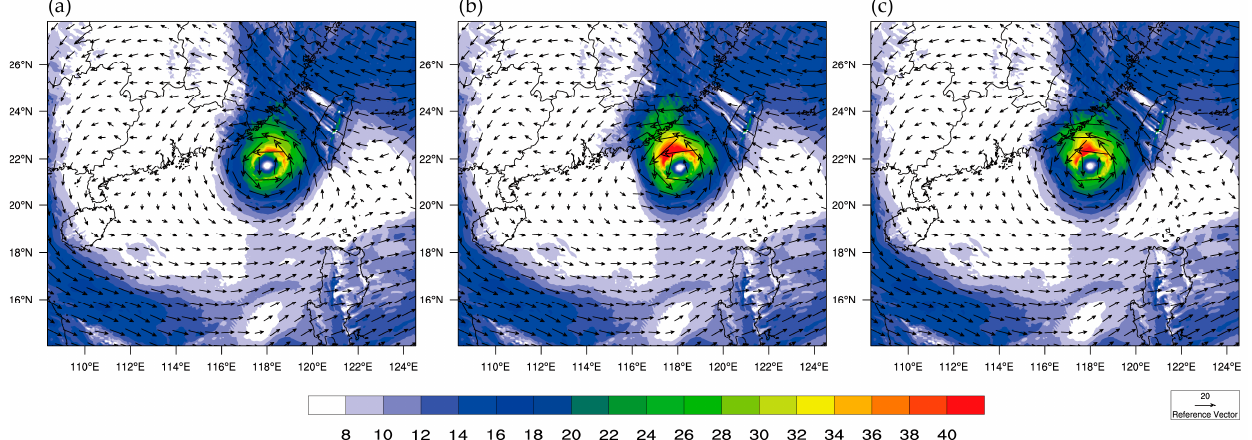
Figure 5. 700 hPa wind speed (shaded, unit: m s − 1 ) and wind vector (arrow, reference vector = 20 m s − 1 ) of the ( a ) CTRL, ( b ) DA_len1.0 and ( c ) DA_len0.25 experiments at 1800 UTC on 8 July 2015.